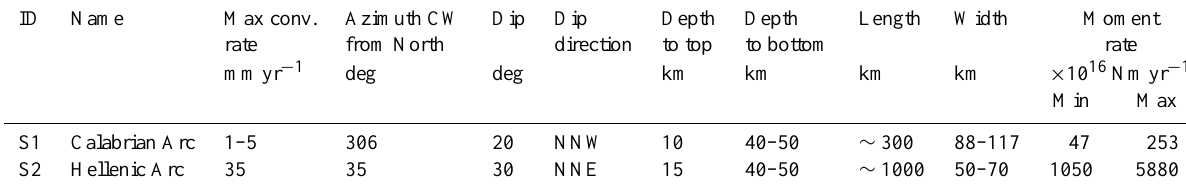
Table 4. Parameters of subduction sources (see Fig. 3 for